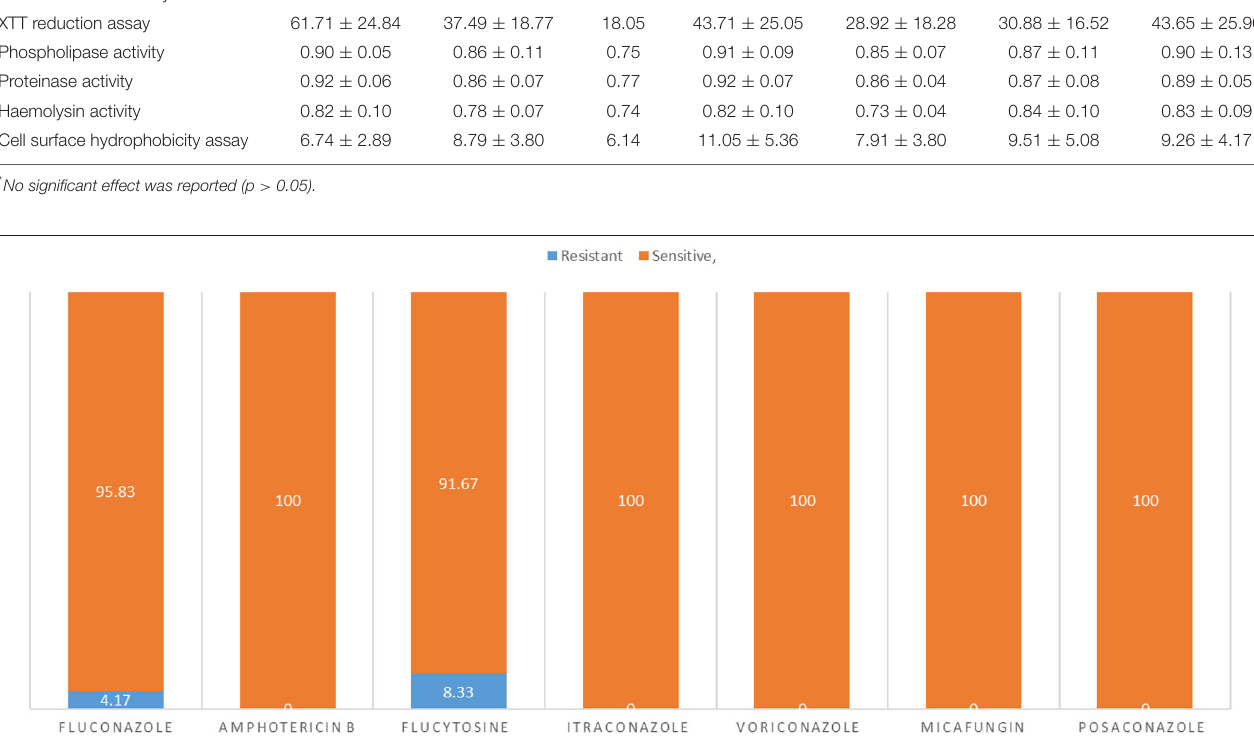
FIGURE 9 | The sensitivity and resistant of C. albicans isolates to different types of